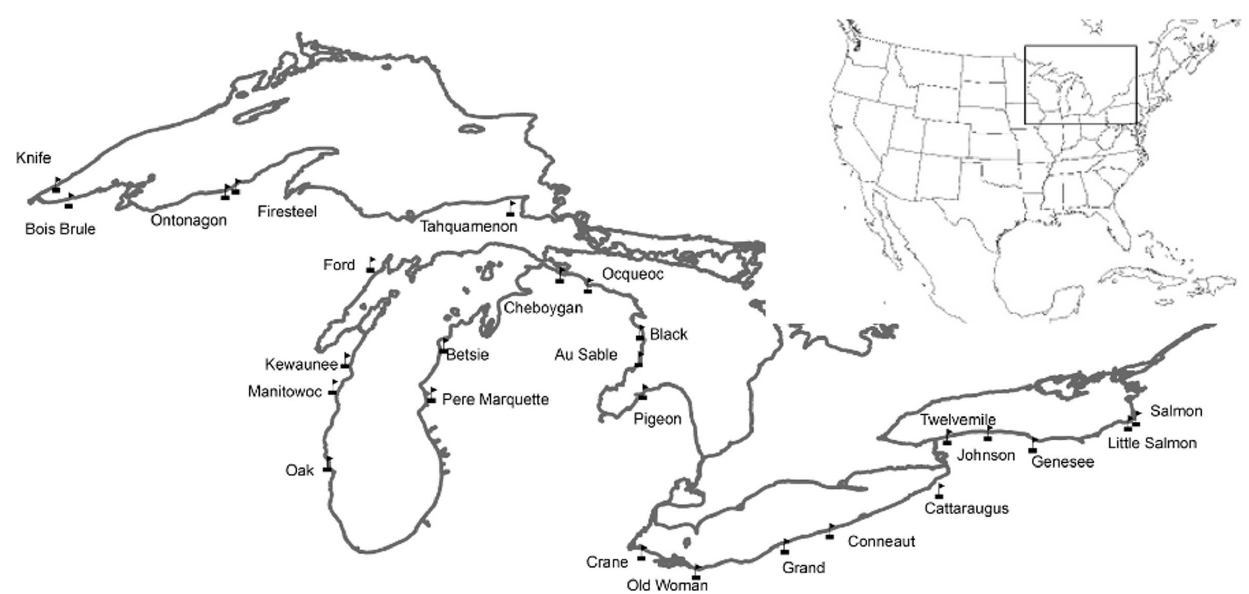
Figure 1. Map of sites sampled during this study.